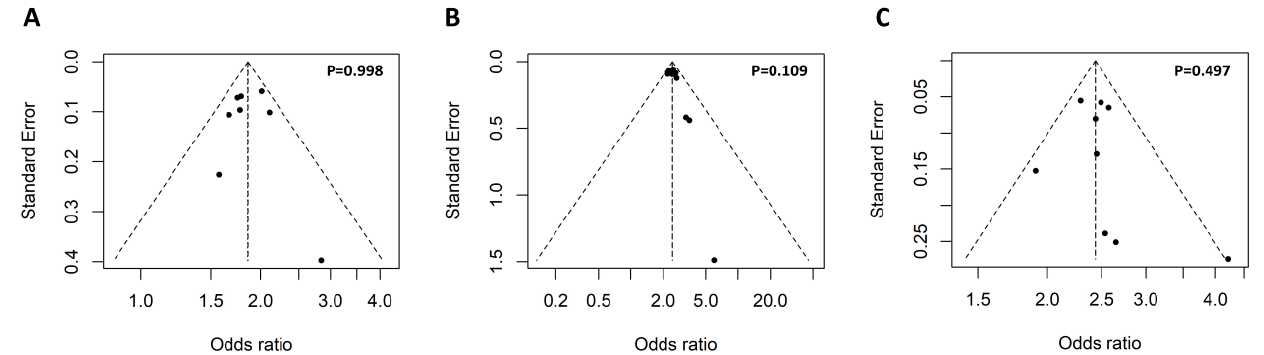
Figure 3. Symmetrical funnel plot used to assess publication bias. The funnel plot of the association of the GTF2I rs117026326 polymorphism with pSS ( A ) and SLE ( B ), as well as association of the NCF1 rs201802880 polymorphism with SLE ( C ). Egger’s regression test was used to assess potential publication bias via funnel plot asymmetry, and a p -value less than 0.05 indicates presence publication bias.